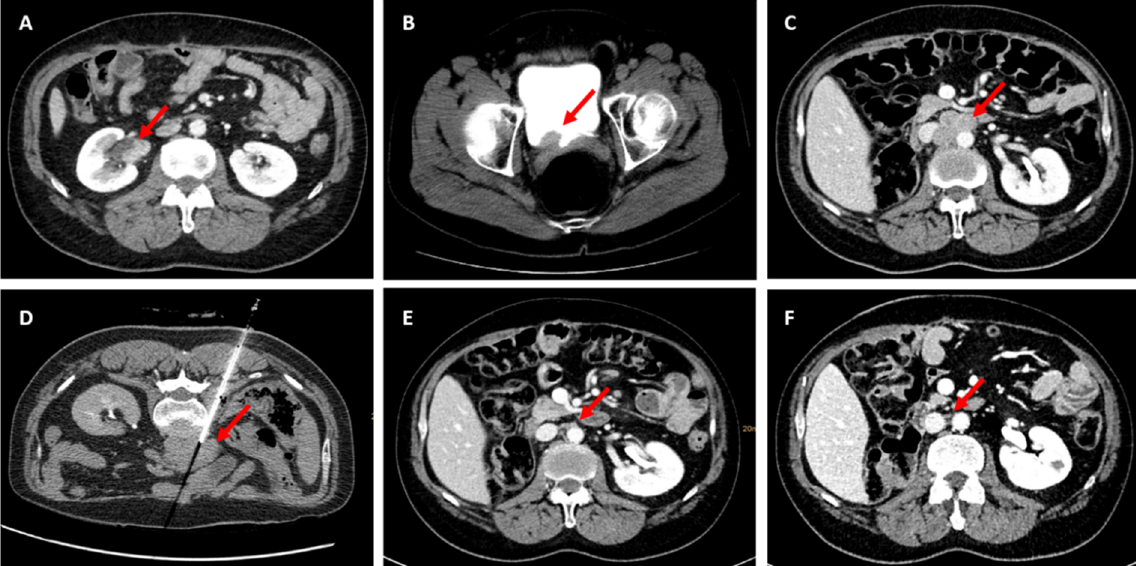
Figure 5. Frequent computed tomography (CT) scans of a patient diagnosed with LS during intravenously administered therapy with pembrolizumab. ( A ) Axial CT scan with an enlarged mass of the right renal pelvis (red arrow) in first diagnosis. ( B ) Axial CT scan prior to electroresection of the bladder, showing an enhancing mass (red arrow) at the region of the right ureter ostium. ( C ) Retroperitoneal lymph node bulk (red arrow) occurring three months after cystoprostatectomy. ( D ) CT-guided biopsy of the interaortocaval lymph nodes (red arrow). ( E ) Normal sized lymph nodes (red arrow) after five cycles of pembrolizumab 200 mg. ( F ) Remaining normal sized lymph nodes (red arrow) after 28 cycles pembrolizumab 200 mg with no other signs of regional or local metastasis.